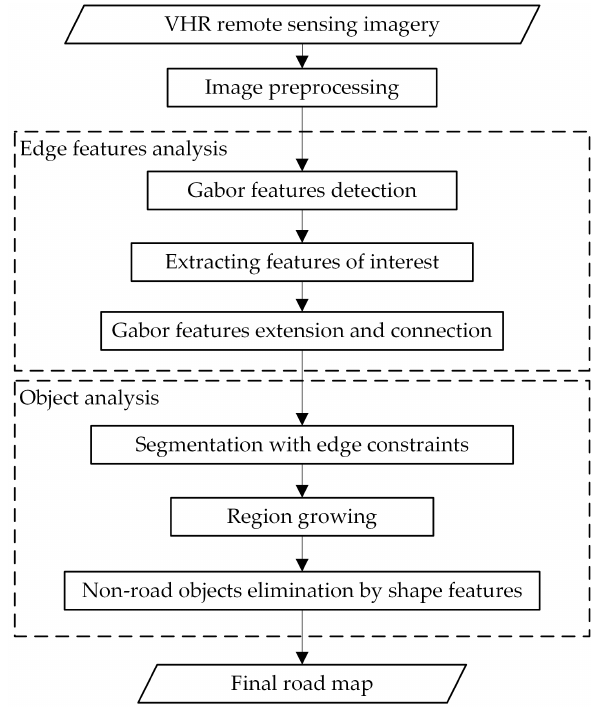
Figure 1. Flowchart of the proposed